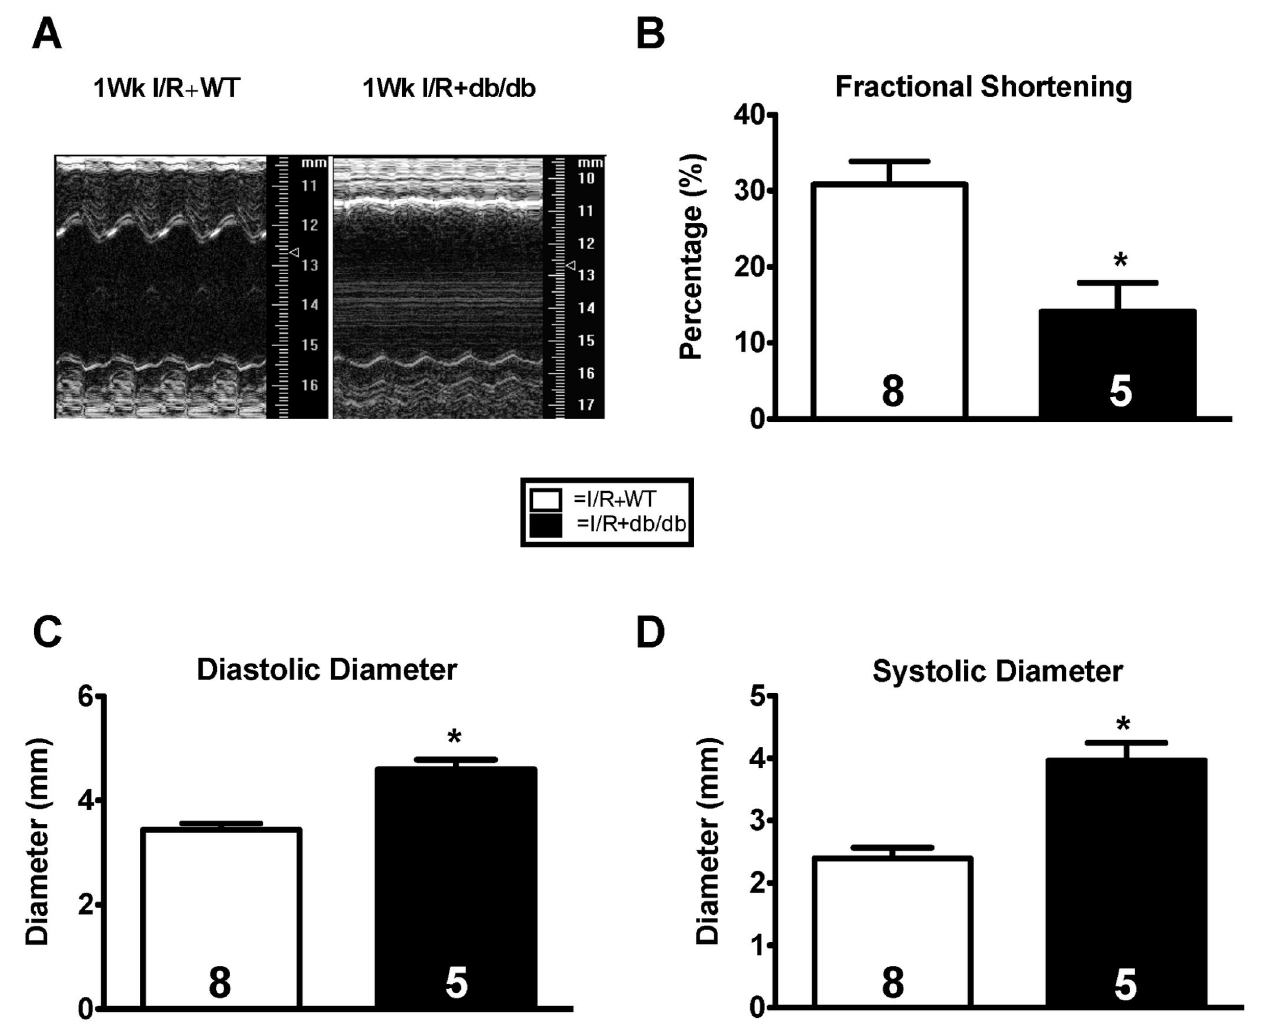
Figure 5. Ischemia reperfusion injury is exacerbated by hyperglycemia and obesity. db/db or heterozygous nondiabetic littermates were subjected to ischemia/reperfusion injury. ( A ) Long axis m-mode utilizing the Vevo 770 imaging system. ( B - D ) Fractional shortening was significantly decreased while diastolic diameter and systolic diameter were significantly increased in the IR+db/db group compared to the IR+nondiabetic group. Results are expressed as means ± S.E., *, p< 0.05.